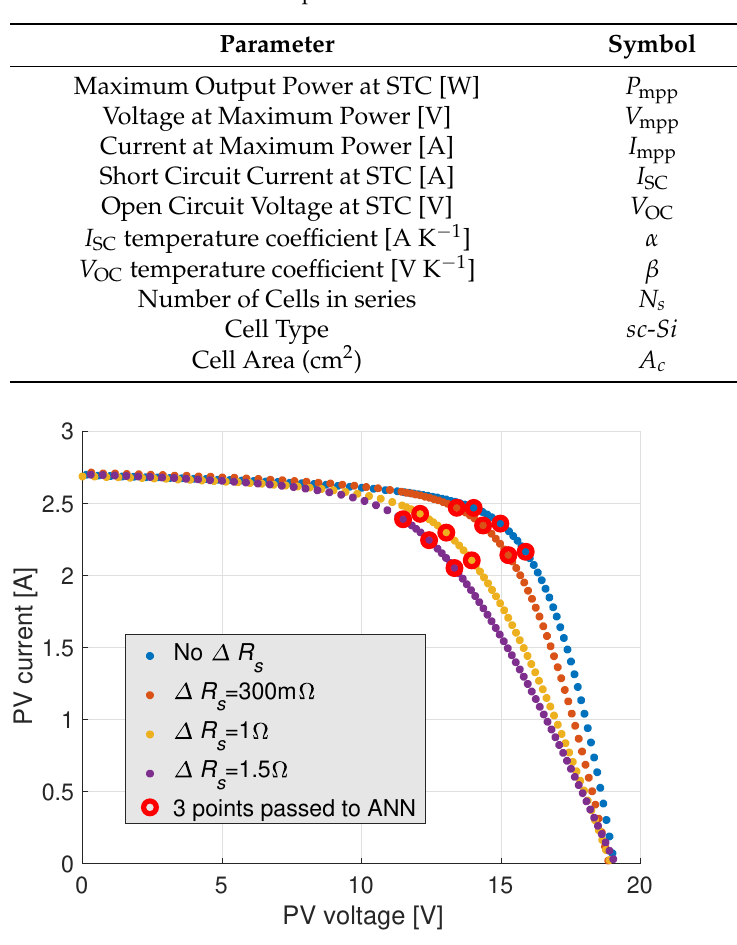
Table 12. Isofotón I-53 main specifications.